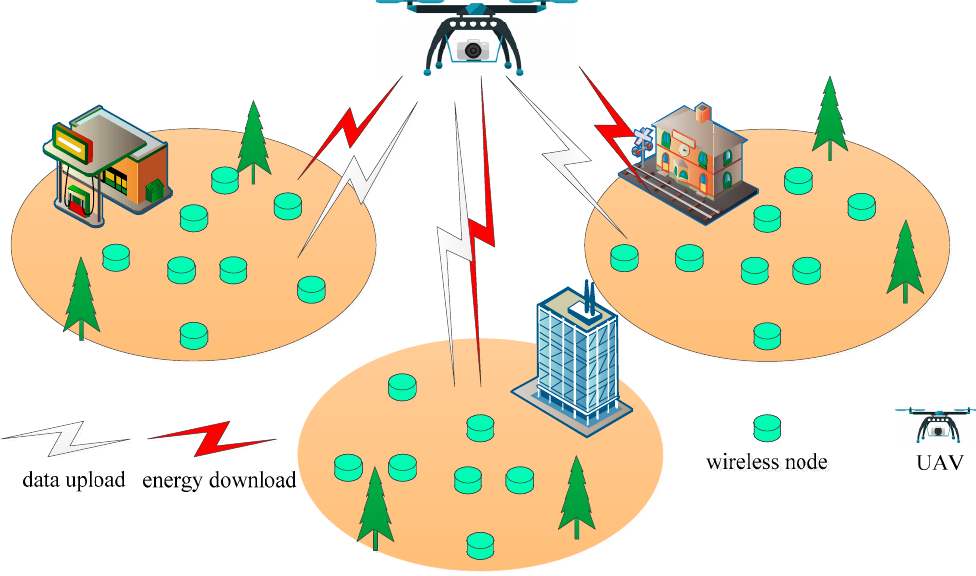
Figure 1. System model. UAV, unmanned aerial vehicle.